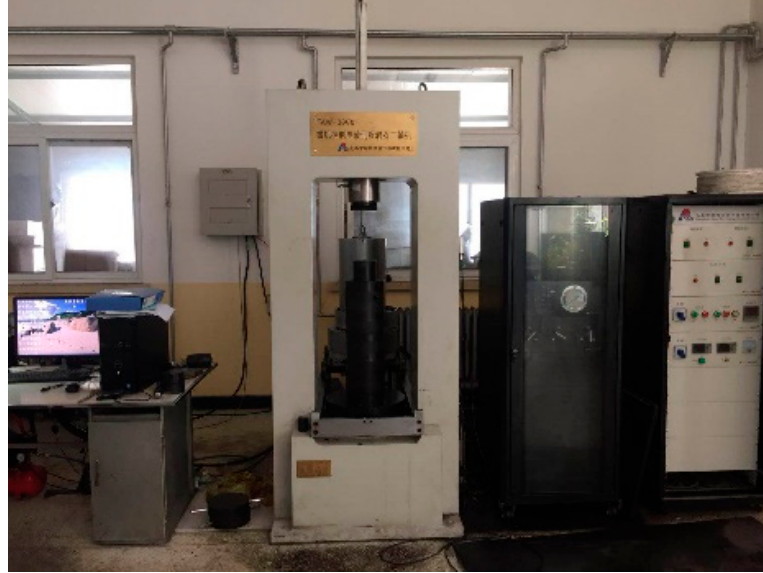
Figure 4. TAW-3000 electro-hydraulic servo rock triaxial testing machine.